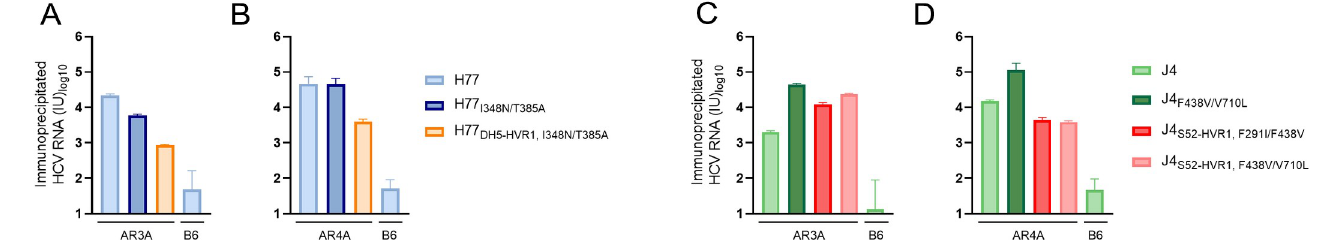
Fig 10. HVR1 swaps and associated adaptive envelope mutations have divergent effects on immunoprecipitation of HCVcc particles. Immunoprecipitation of H77 (A and B) and J4 (C and D) HCVcc recombinants with the indicated substitutions using AR3A and AR4A (B6 is a control for nonspecific binding). Magnetic beads were coated with the indicated mAbs and incubated with 10 6 IU HCV RNA from infectious cell culture supernatant containing (A and B) H77, H77 I348N/T385A or H77 DH5-HVR1, I348N/T385A or (C and D) J4, J4 F438V/V710L , J4 S52-HVR1, F291I/F438V or J4 S52-HVR1, F438V/V710L . The amount of immunoprecipitated HCV RNA was measured by HCV RNA extraction of eluted fractions from the beads and reverse-transcription qPCR in duplicates as described in “HCV immunoprecipitation” in the Methods section. The data are shown as mean of technical duplicates with standard deviation (cut-off was 62 IU). The data shown is a representative experiment out of 2.